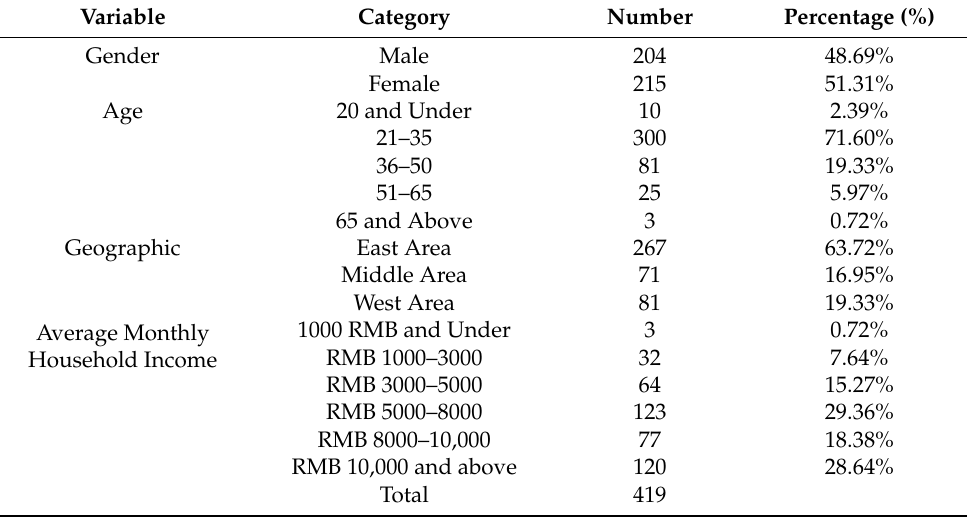
Table 2. Demographic Information of